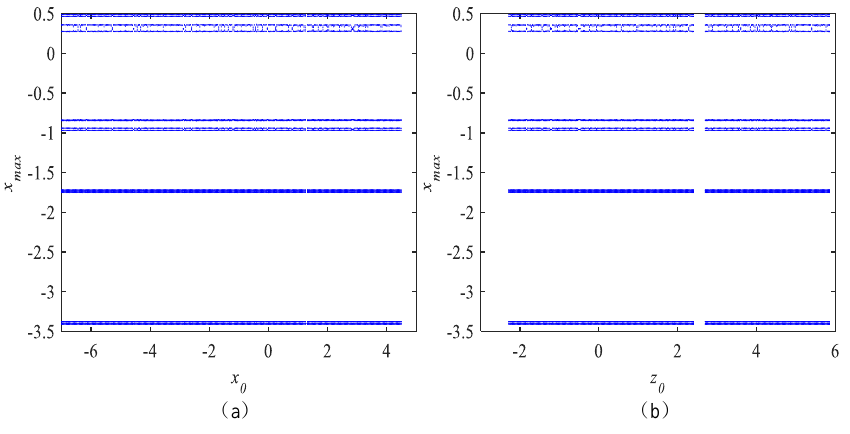
Figure 6. Bifurcation diagrams with x 0 and z 0 change: ( a ) x 0 change; ( b ) z 0 change. Set the same system parameters and order as before, the initial conditions are assigned as x 0 = 1, z 0 = 1, w 0 = 4. y 0 varies at the range [ − 7, 9]. The bifurcation diagram and the LEs of the system (8) are shown in Figure 7. In the interval [ − 7, − 4], the bifurcation behavior of the system is special. When the initial condition y 0 increases from − 7, the system breaks into chaos at first through a period-doubling bifurcation. The bifurcation paths have many narrow periodic windows, and the bifurcation points corresponding to these windows form another bifurcation path with a breakpoint. Then, the system suddenly jumps to another chaotic state. As y 0 continues to increase, the bifurcation becomes normal. There are three obvious periodic windows, and the system quickly evolves into chaotic state again through the period-doubling bifurcation. The LEs shown in Figure 7b verify the accuracy of bifurcation diagrams.